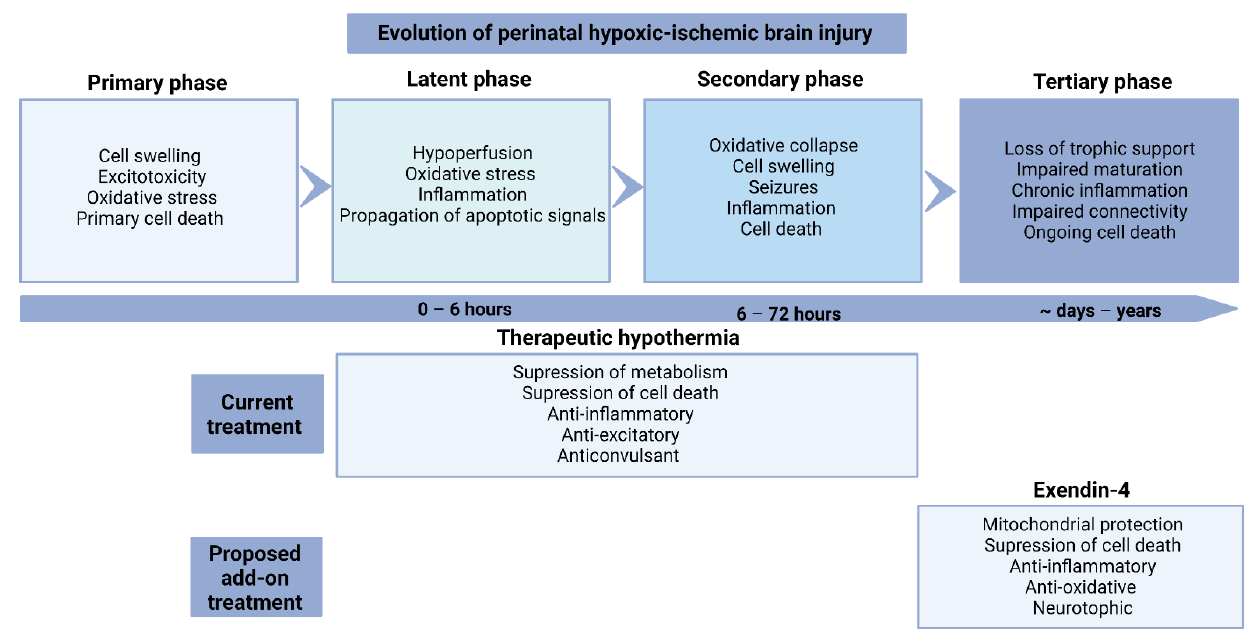
Figure 1. The evolution of perinatal hypoxic-ischemic brain injury and the effects of the current treatment (therapeutic hypothermia) and potential treatment (Exendin-4).